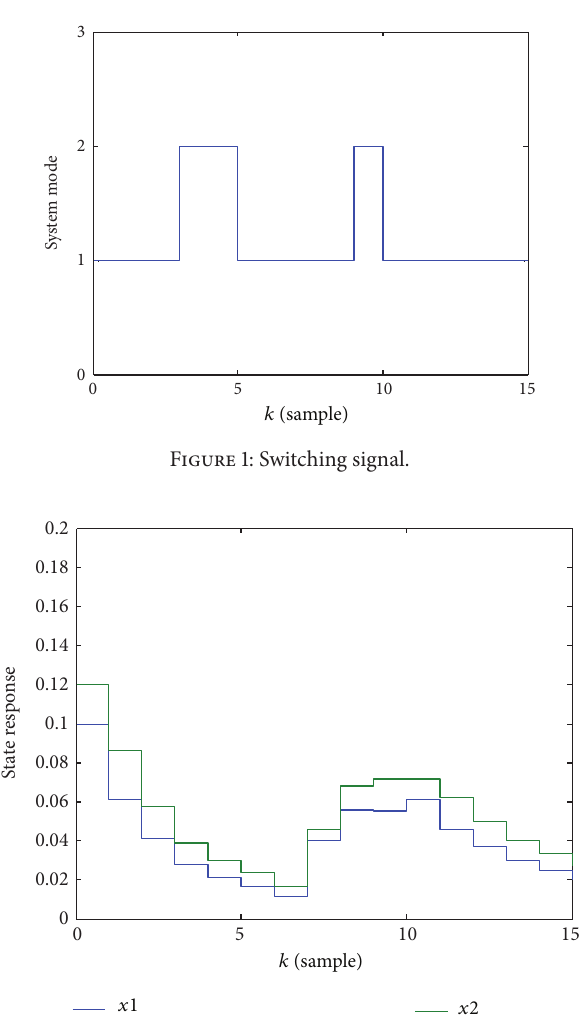
Figure 2: State response of the closed-loop